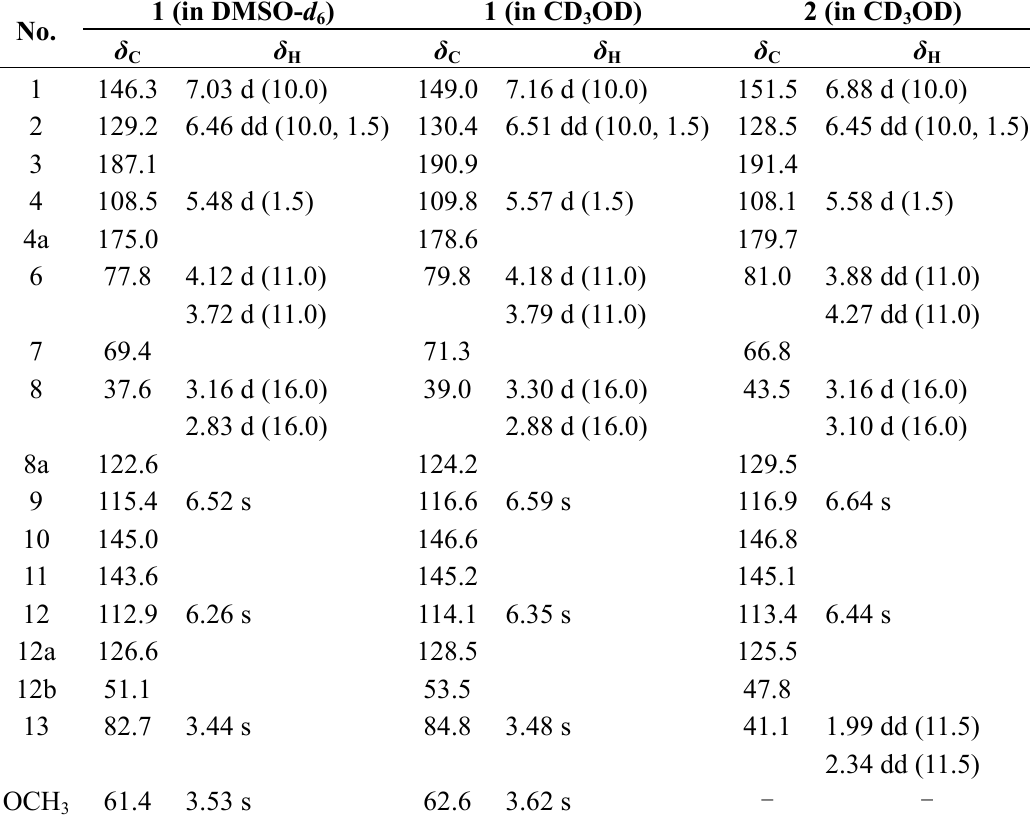
Table 1. 1 H-NMR (500 MHz) and 13 C-NMR (125 MHz) data for 1 and 2 ( δ in ppm and J in